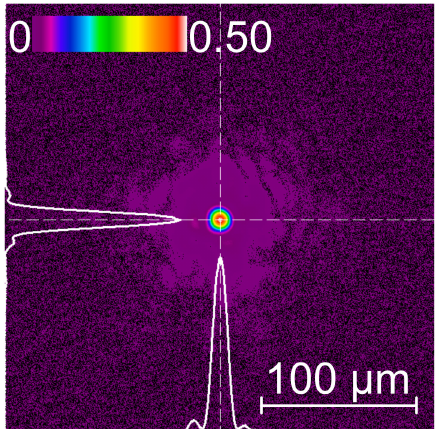
Figure 12. Focal spot with wedged crystals measured after an f = 2.6-m, off-axis parabola. The Strehl ratio is 0.50.